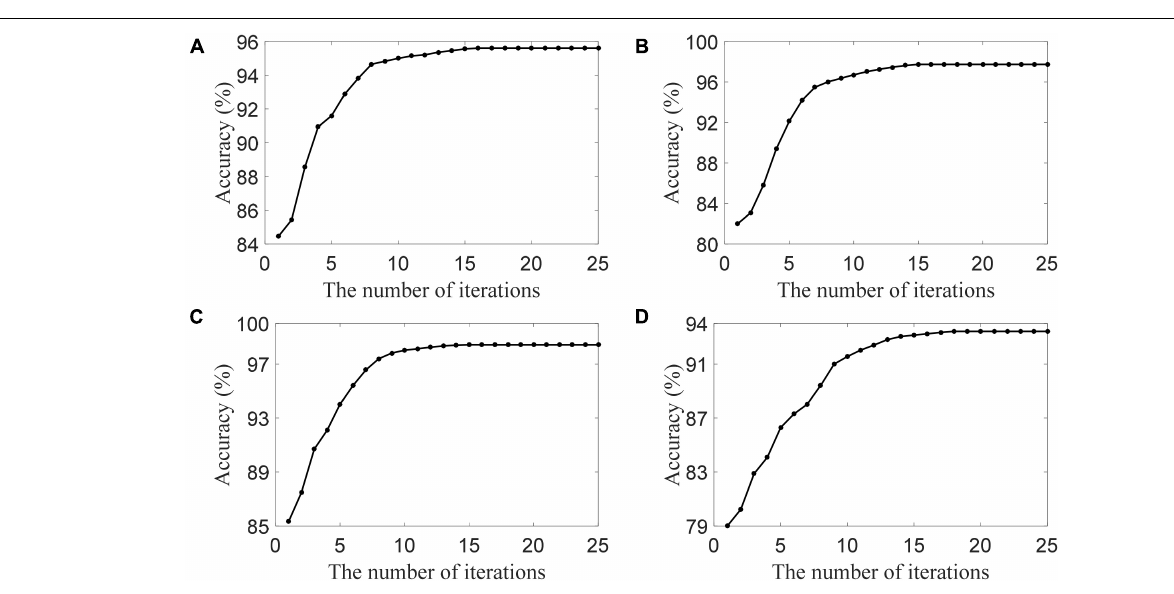
FIGURE 4 | G-mean of DSLRR with ablation experiment in four EEG datasets.